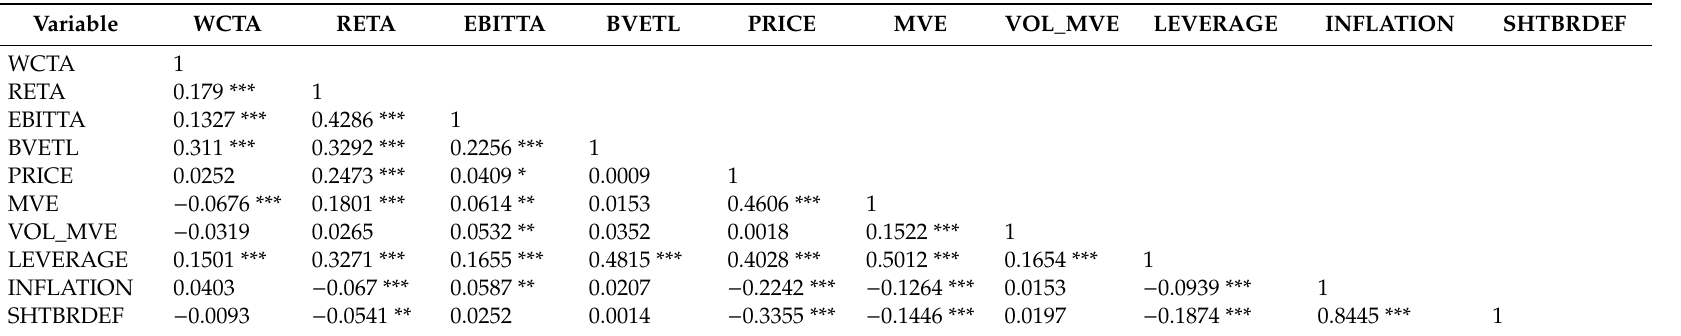
Table A1. Correlation matrix during crisis, 2007–2009.